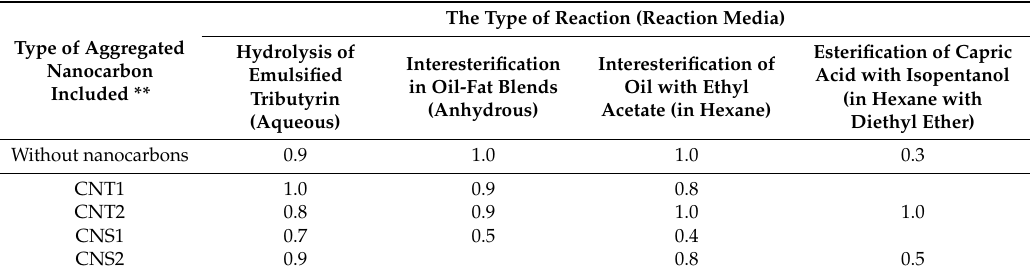
Table 5. Relative activity * of r E. coli /lip lysate-based biocatalysts in various